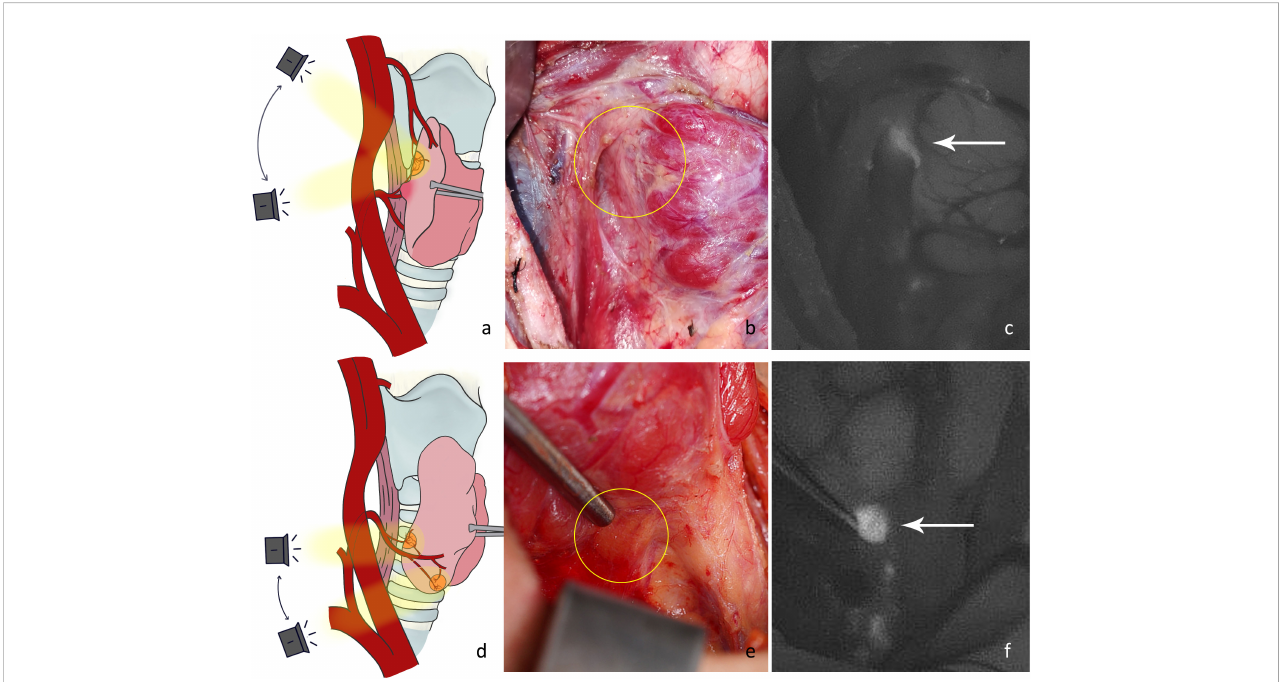
FIGURE 2 (A) Schematic diagram of the imaging angle for the right superior parathyroid gland. (B) Location of a type A gland in normal white light (yellow circle). (C) NIRAF showing a cordlike type A gland (white arrow). (D) Schematic diagram of the imaging angle for the right inferior parathyroid gland. (E) Location of the type C1 gland under normal white light (yellow circle). (F) NIRAF shows a type C1 gland (white arrow).